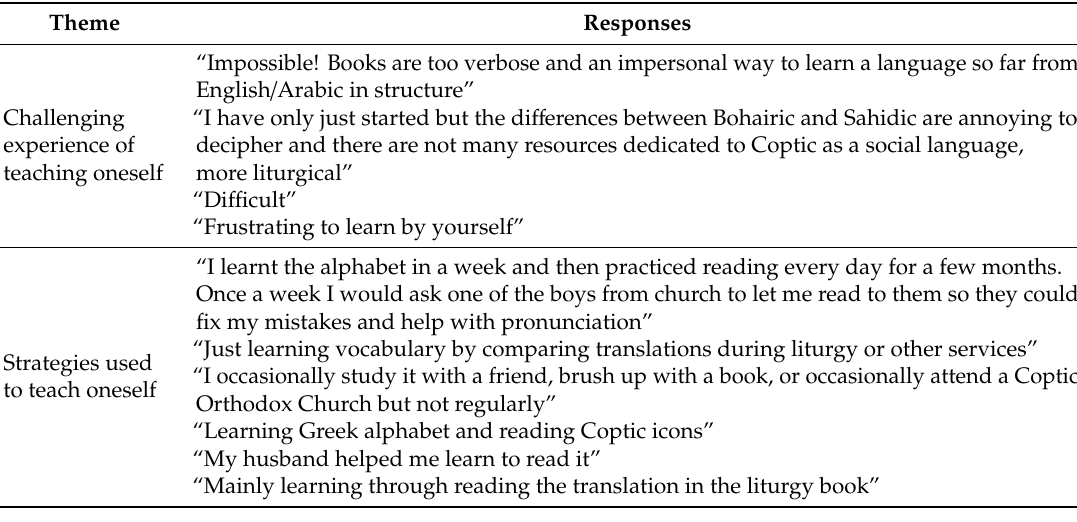
Table 1. Description of experience teaching oneself the Coptic